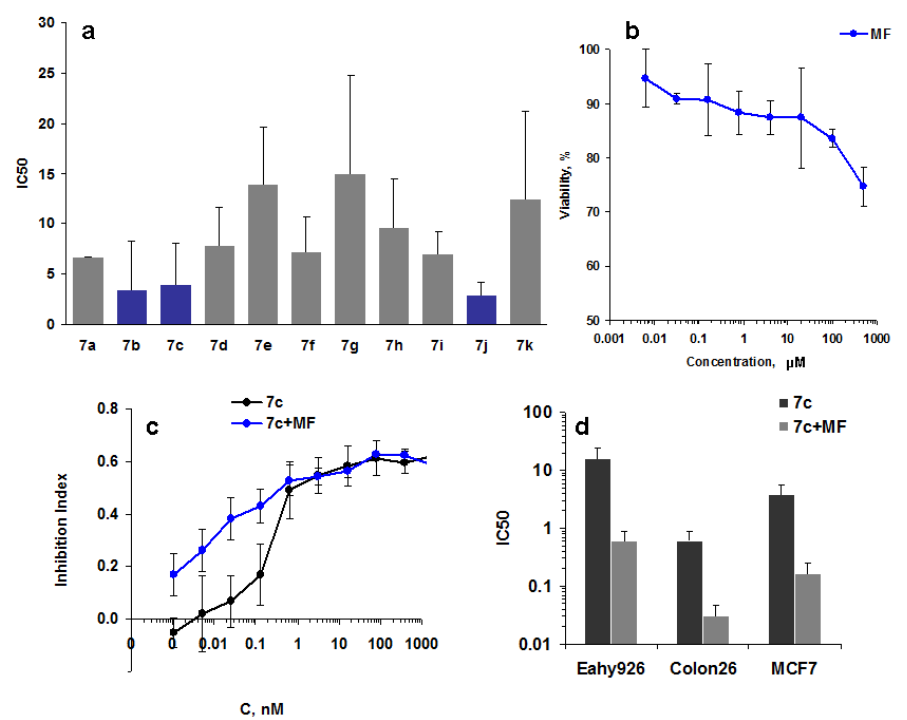
Figure 3. Characteristics of cytotoxicity. ( a ) Average IC 50 for the compounds 7a – 7k . The most active compounds are shown in blue. ( b ) Synergistic effect of 1 mM metformin (MF) and 4 nM compound 7c on the growth of MCF7 cells. ( c ) Effect of 300 µ M MF on MCF7 proliferation. ( d ) IC 50 for 7c and 7c + MF 300 µ M for Eahy926, Colon26, and MCF7.